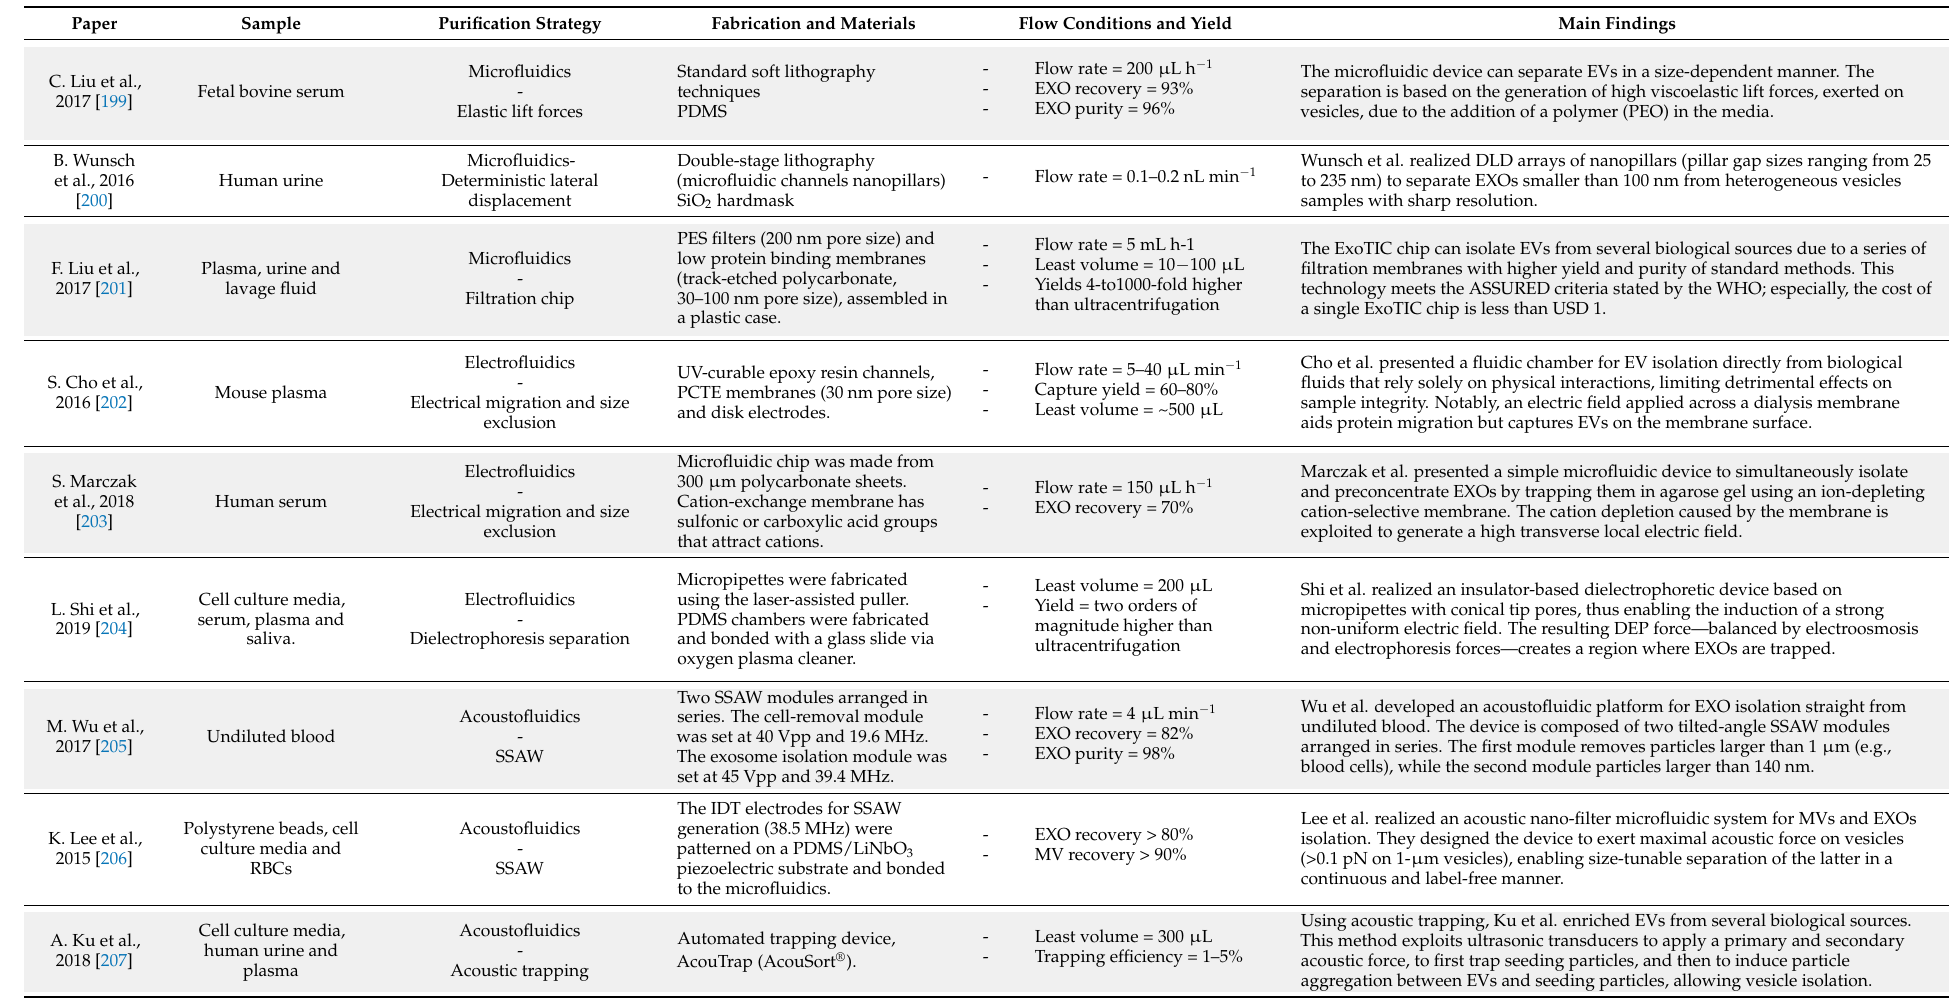
Table 6. Summary of selected label-free devices for exosome purification from culture media and body